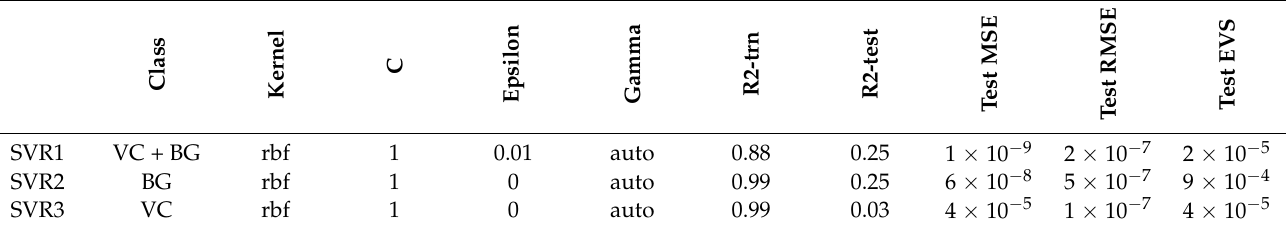
* Table Legend: Regression Function (Kernel), Regularization Factor (C), Allowed Error Margin (Epsilon), Loss Function (Gamma), Train Score (R2-trn), Test Score (R2-test), Mean Square Error (MSE), Root MSE (RMSE), Explained Variance Regression Score (EVS), Support Vector Regression (SVR), Vegetation Covered (VC), and Bare Ground (BG).